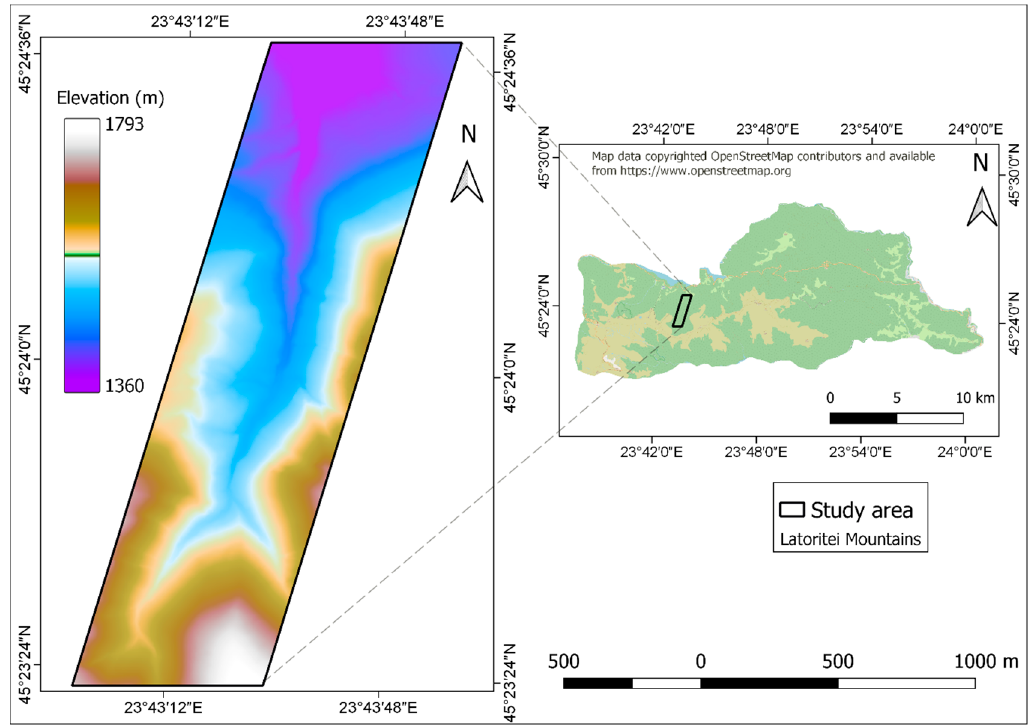
Figure 1. Test site location.